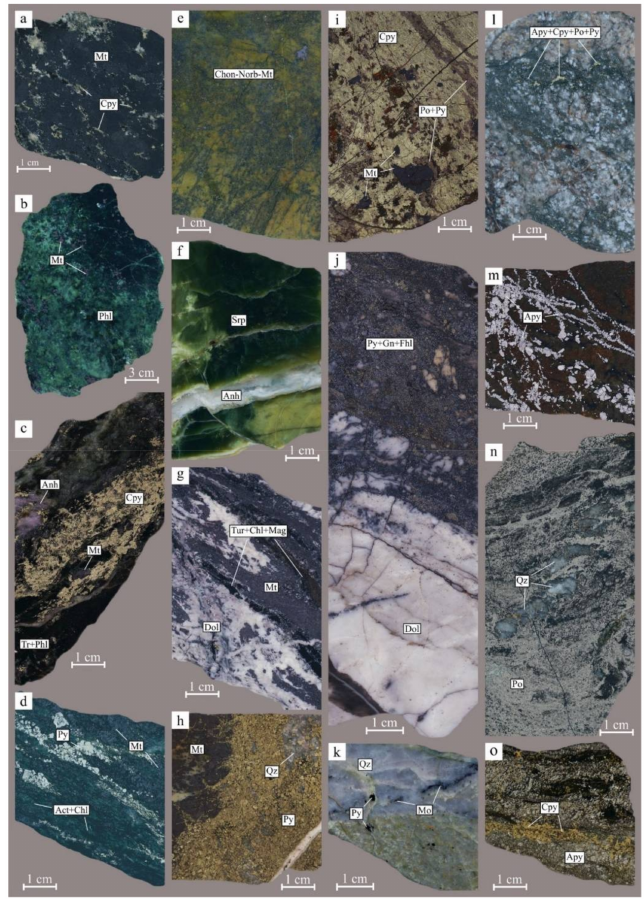
Figure 8. Ore samples and hydrothermal altered rocks of the Kultuma deposit. Kultuma